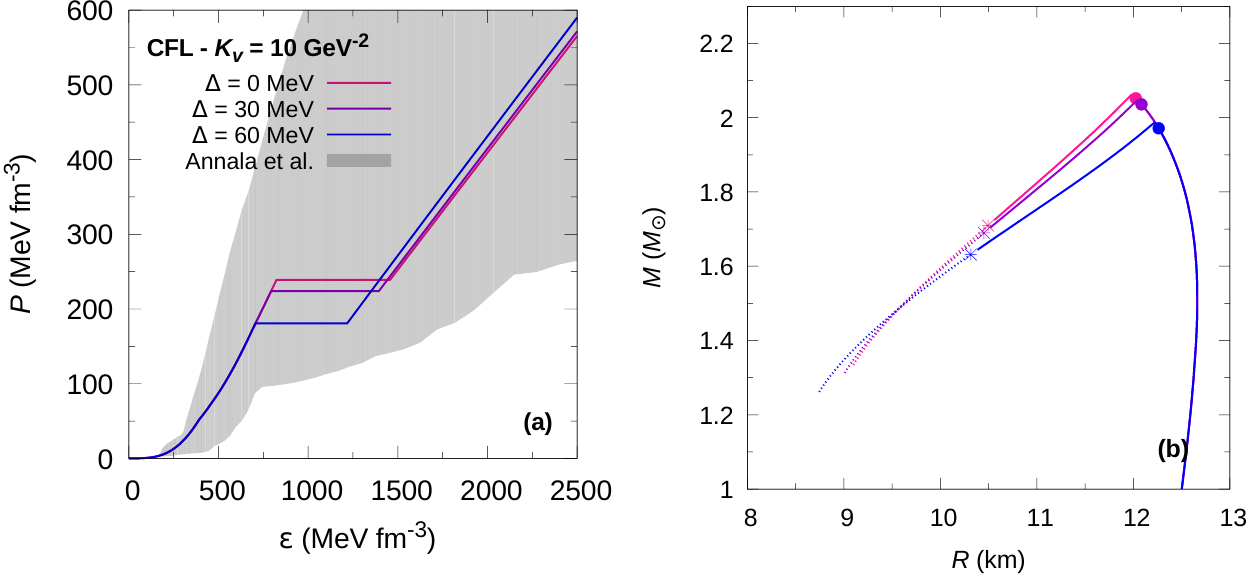
Figure 4. (Hybrid EoS) (panel ( a )) and mass-radius relationship (panel ( b )) for the CFL phase at fixed gap value of K v = 10 GeV − 2 , for different values of the ∆ parameter. In panel ( a ), the grey region shows the constraints presented in [42]. The solid dots in panel ( b ) indicate the appearance of the color superconducting phase, just before the maximum mass peak. For rapid conversions, the stellar configurations to the left of each maximum mass are unstable and the existence of HSs is only marginal. For slow conversions, an extended stability branch exists. The stable configurations are shown by continuous lines. The terminal configurations are marked with